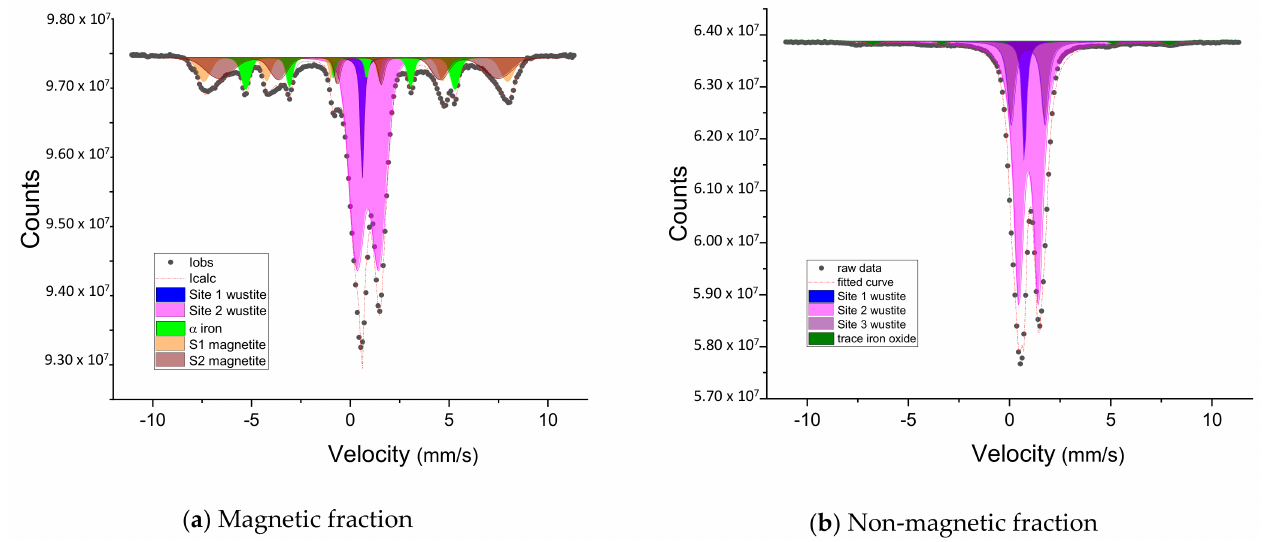
Figure 1. Mössbauer spectra of the magnetic ( a ) and non-magnetic ( b ) fractions.